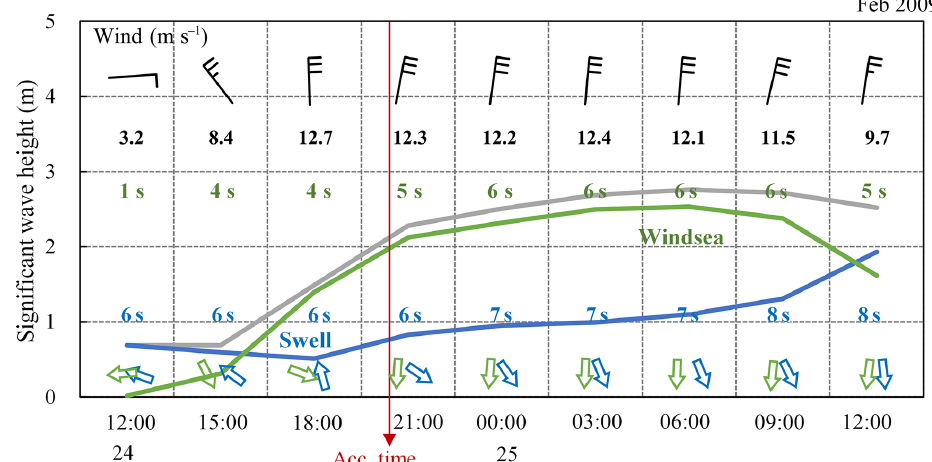
Figure 4. Time series of sea surface wind and sea state at the ship accident location over 24h for the case occurred at 20:30UTC on 24 February 2009. At the top of the figure, wind vanes and numbers indicate wind direction and wind speed at the accident location. Three polylines that represent the significant wave height of total sea, wind sea and swell, respectively, in grey, green and blue. The numbers in green and blue are the mean wave period of wind sea and swell. At the bottom of the figure, the arrows that in green and blue indicate the mean wave direction of wind sea and swell,